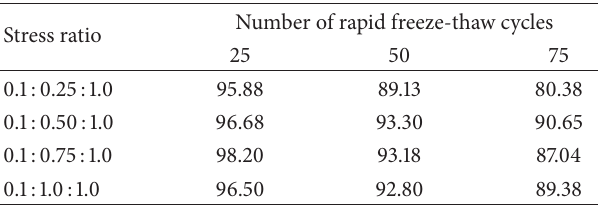
Table 4: Loss of ultimate strength of plain concrete under triaxial compression with rapid freeze-thaw cycles (%). Stress ratio